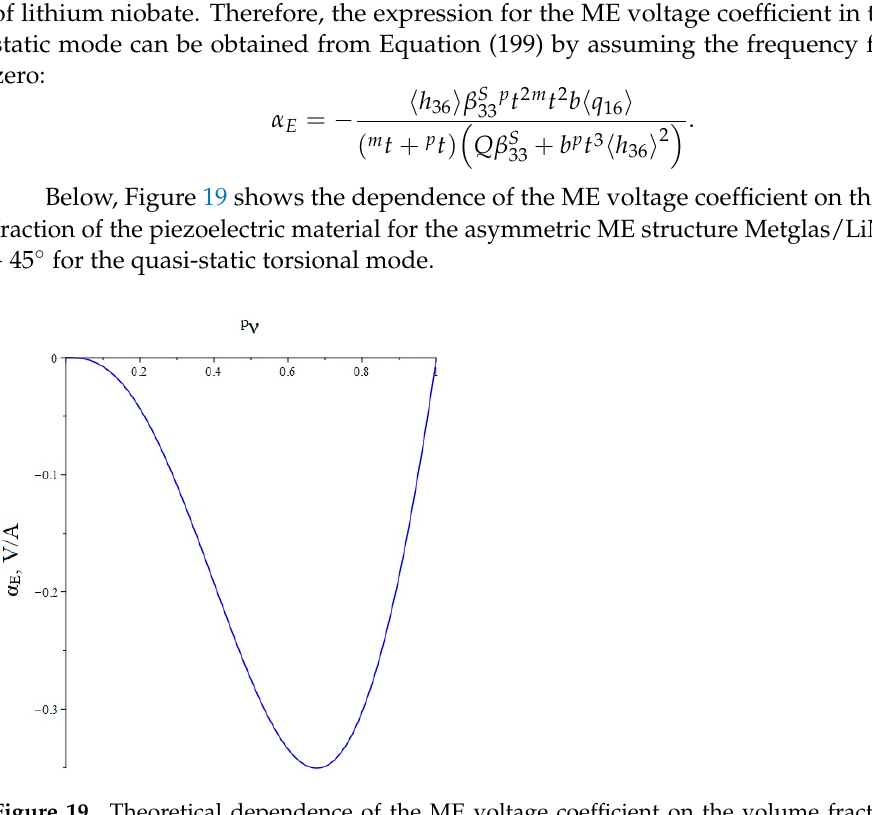
Figure 19. Theoretical dependence of the ME voltage coefficient on the volume fraction of the piezoelectric material for the asymmetric ME structure Metglas/LiNbO 3 Zyl + 45° for the quasi-static torsional mode.